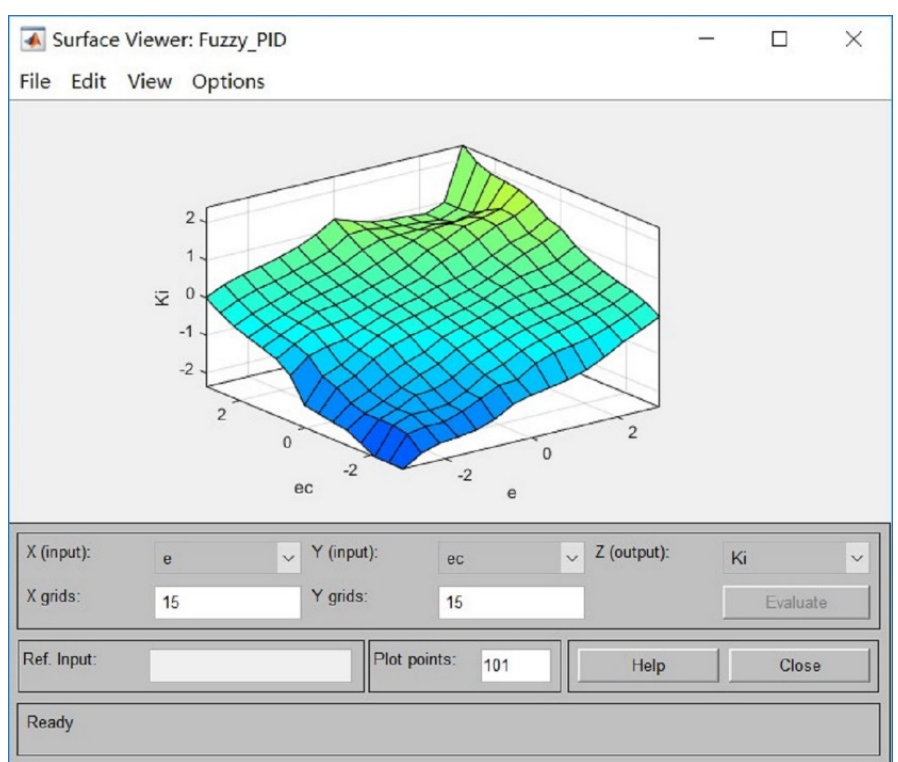
Figure 8. Ki regular surface. Table 2. Kp fuzzy control rules table.